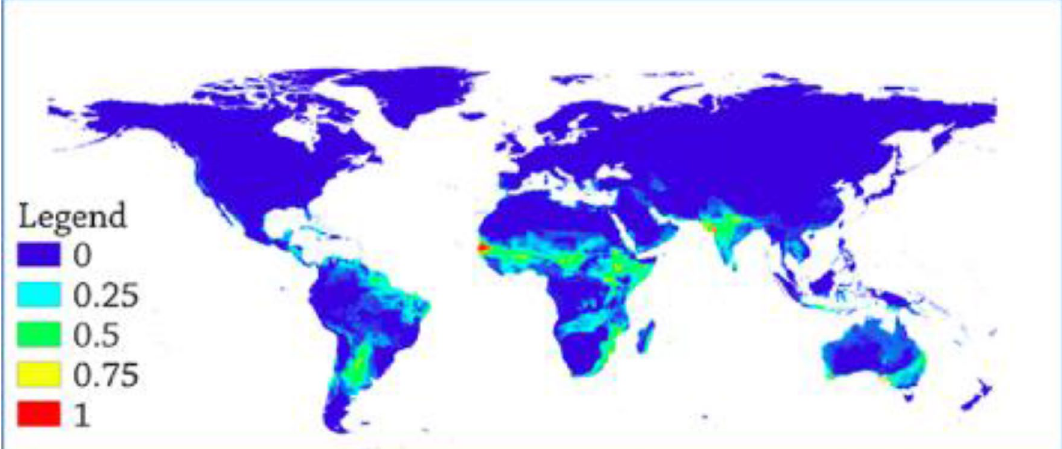
Figure 1. Mean global suitability depiction of AHSv. (The warmer colors depict highly suitable territories while cooler colors depict non suitable locations).